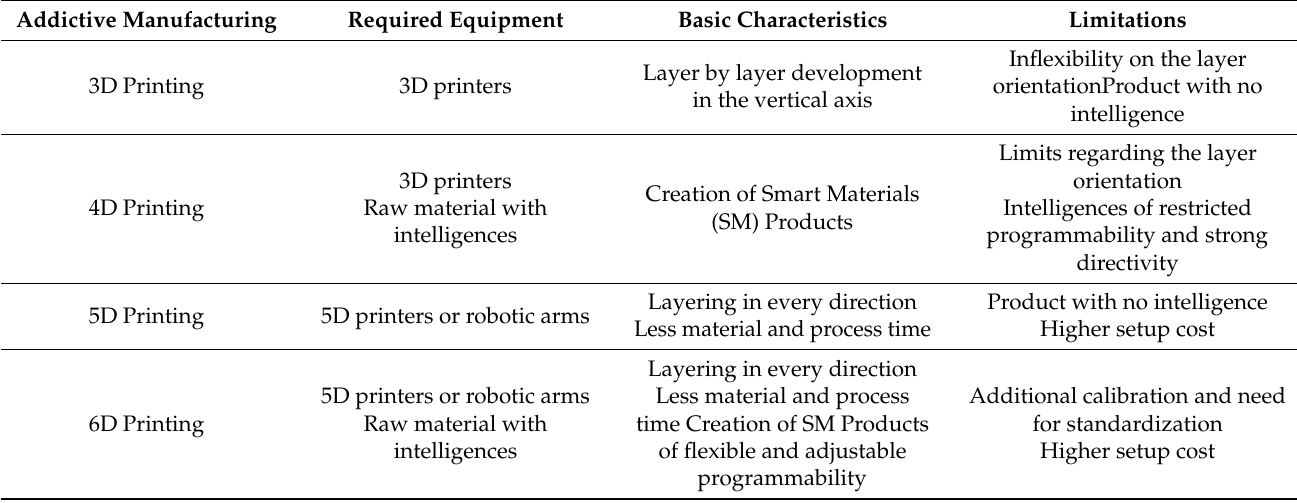
Table 1. Categories of additive manufacturing techniques with their basic features. Addictive Manufacturing Required